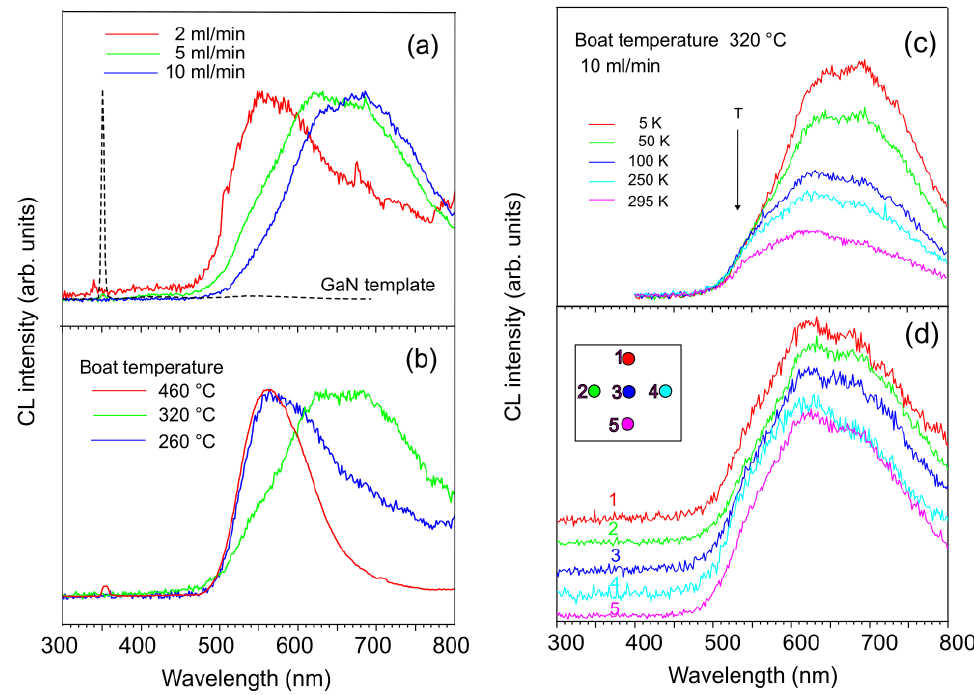
Figure 11. ( a ) Low-temperature CL spectra for samples grown with different HCl flow rates through the boat with In. CL spectrum for the GaN template is shown by the dashed line for reference. ( b ) CL spectra at 5 K for layers grown at different temperatures of the indium boat. ( c ) CL spectra measured at different temperatures for the layer grown with the indium boat temperature of 320 °C and with a constant HCl flow rate of 10 mL/min. ( d ) CL spectra at room temperature measured at different points as schematically indicated in the inset for the same sample as in ( c ).